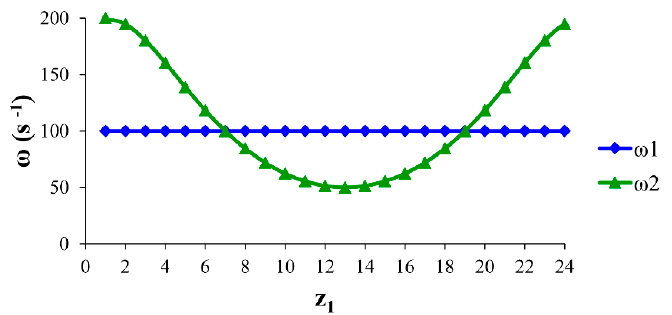
Figure 18. The course of angular velocities in the designed elliptical gear set.